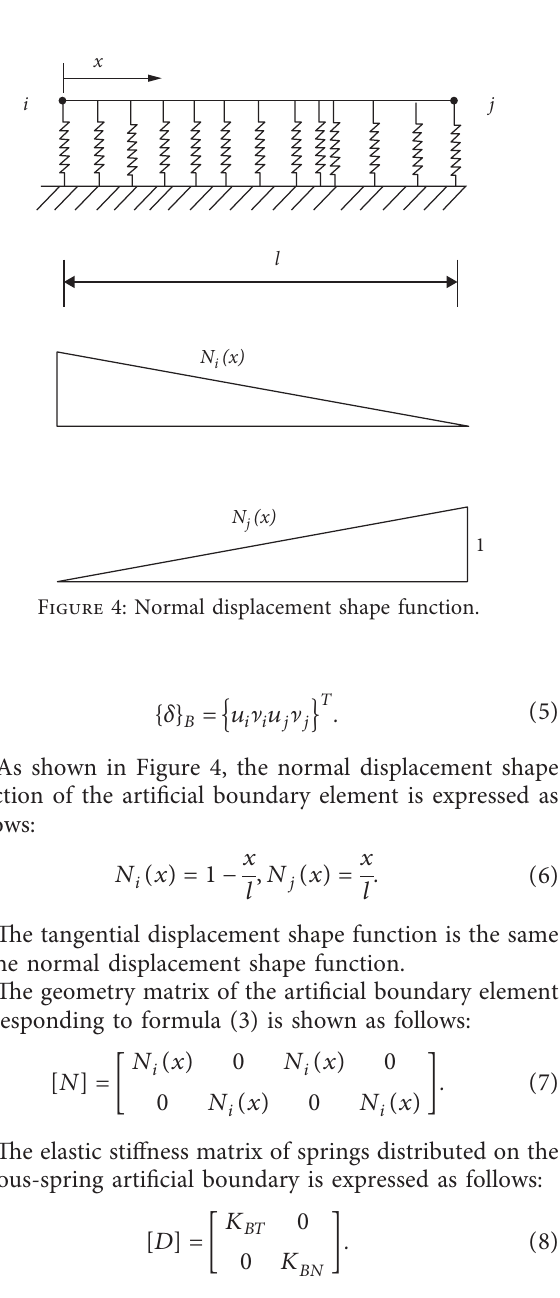
Figure 3: Details of the element (the length l of the element is minimised).